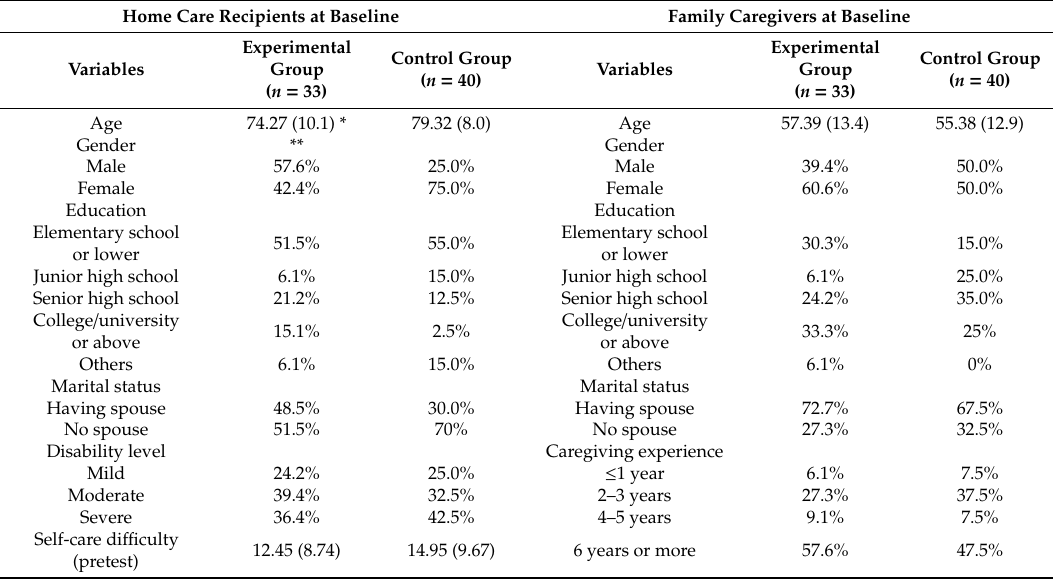
Table 3. Description of the sample: home care users and family